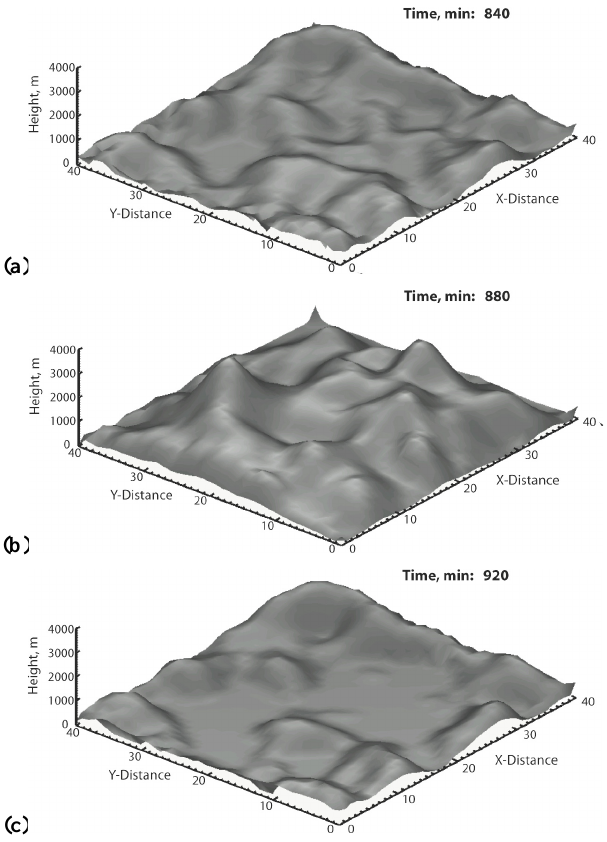
Fig. 12. As in Fig. 11 but for larger domain ( I = 41) and η = − 0 . 22 ± 0 . 03 at (a) 840min, (b) 880min, and (c) 920min. Note the rearrangement of the cells as regions of high H rain out and convert to low H